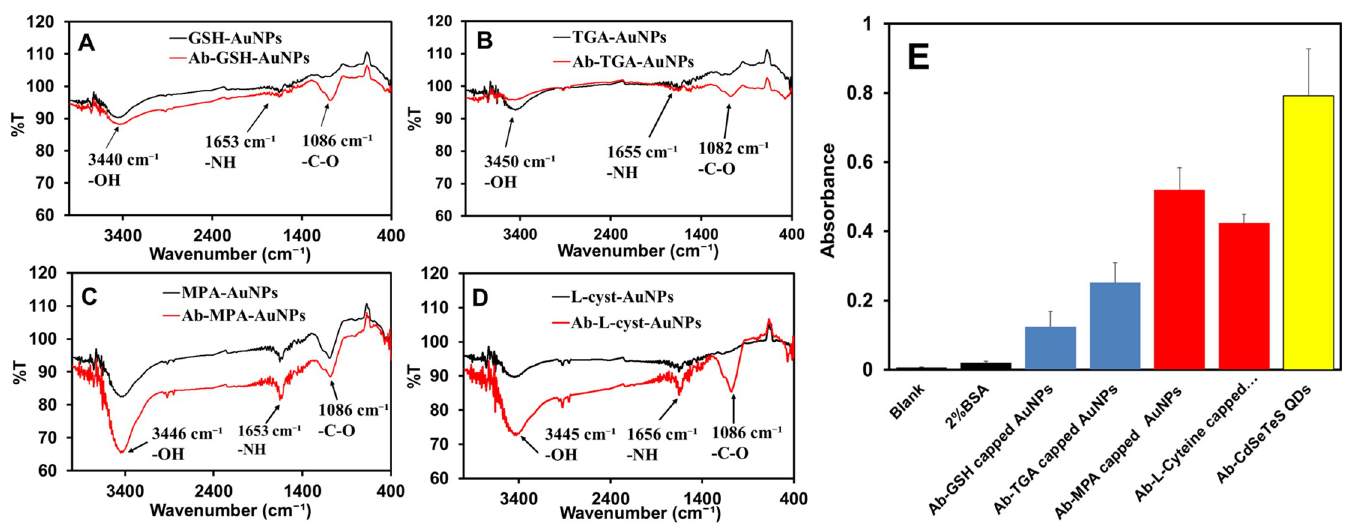
Fig 3. FT-IR spectra of thio-functionalized AuNPs and their binding assay. AuNPs were conjugated by GSH (A), TGA (B), MPA (C), and L -cys (D). (E) ELISA showing the strong binding affinity of the Ab to the QDs and AuNPs. The 2% of BSA was used as a negative control.